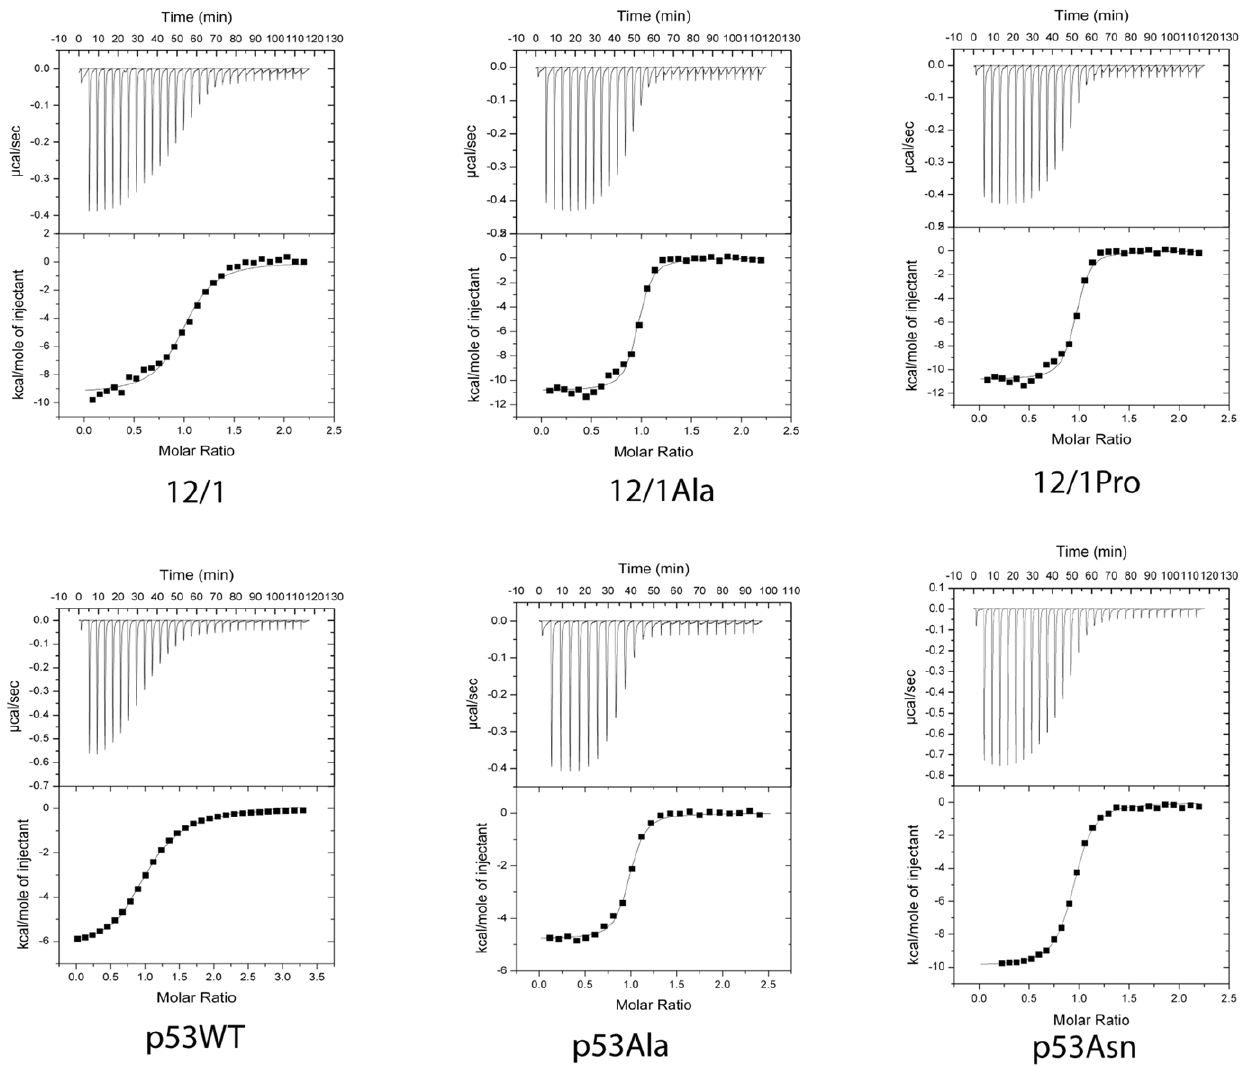
Figure 1. Binding Isotherms of MDM2 with the MDM2 interacting peptides. Isothermal Calorimetry titrations of selected MDM2 binding peptides against MDM2.